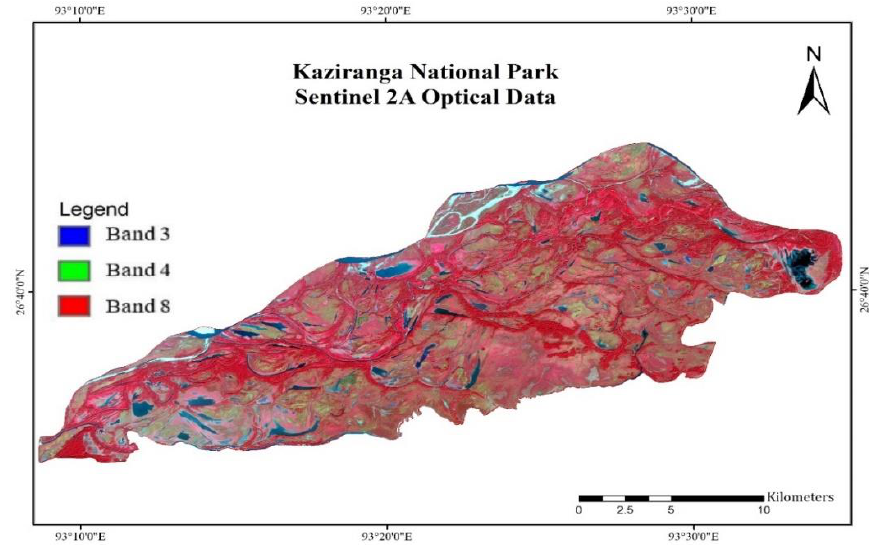
Figure 1. Standard False Colour Composite image of Study Area acquired using